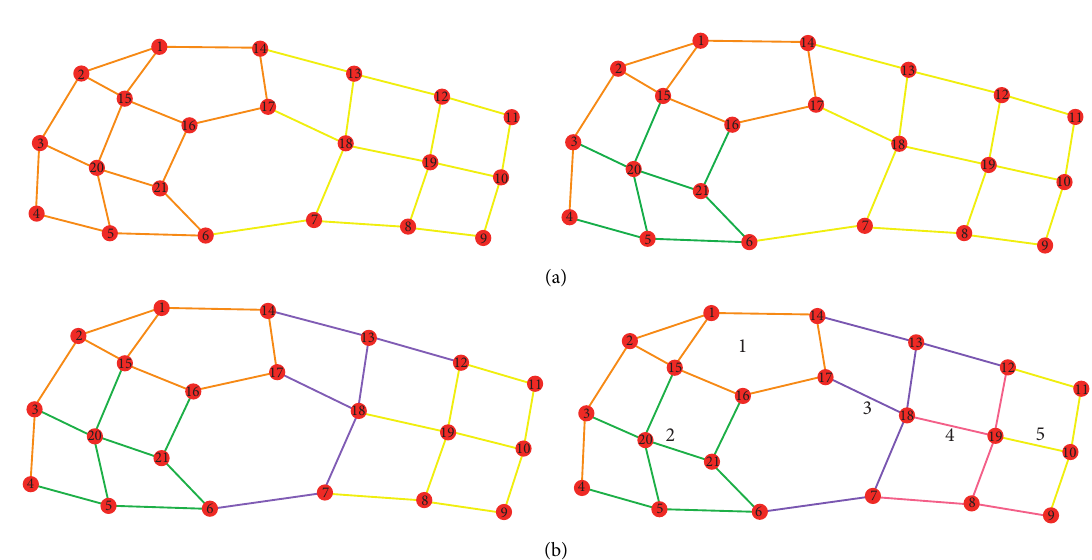
Figure 5: Subregional division of each scheme.